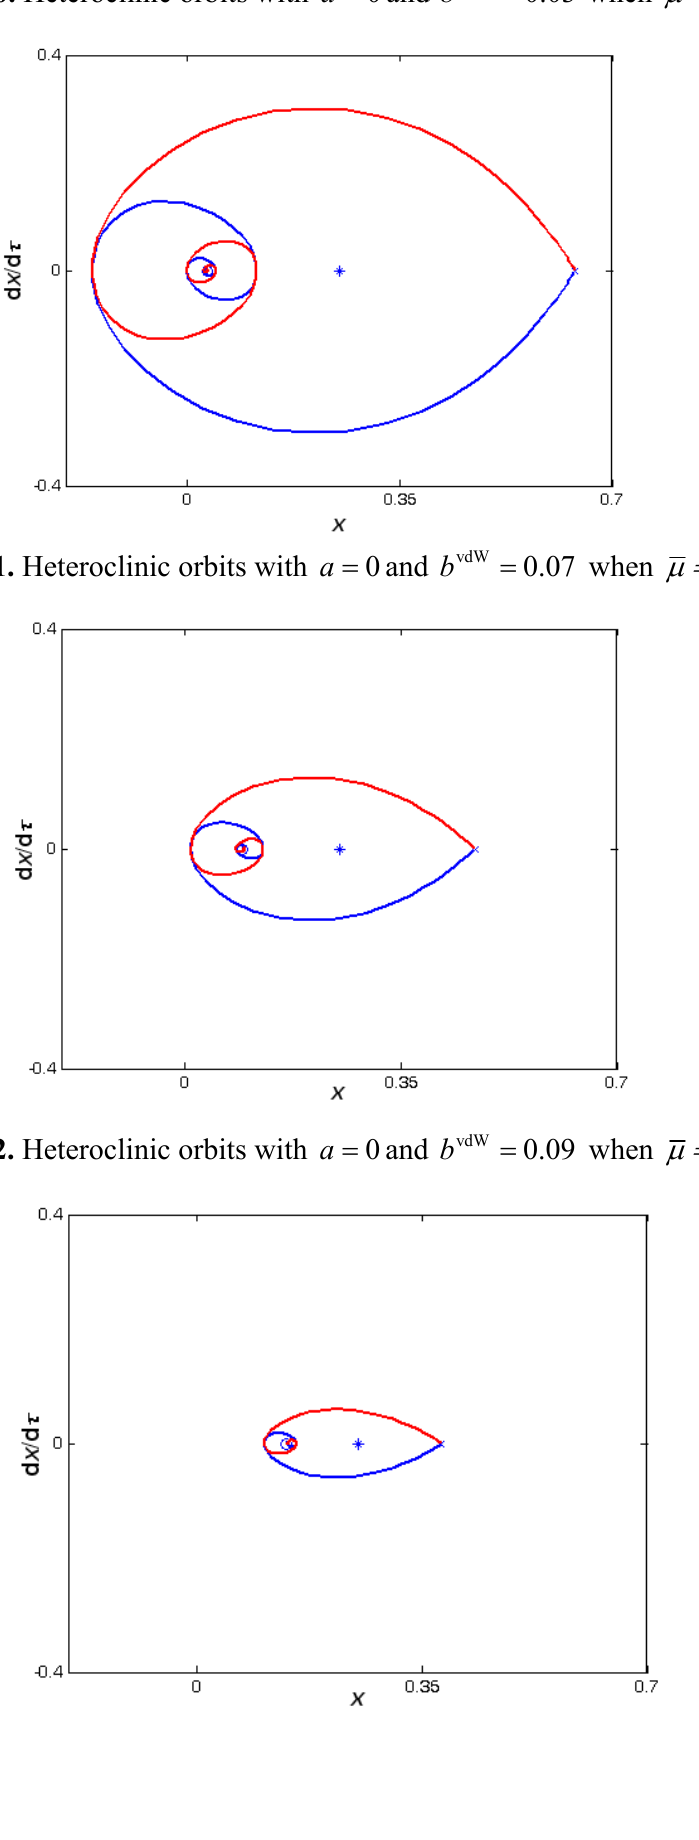
Figure 10. Heteroclinic orbits with